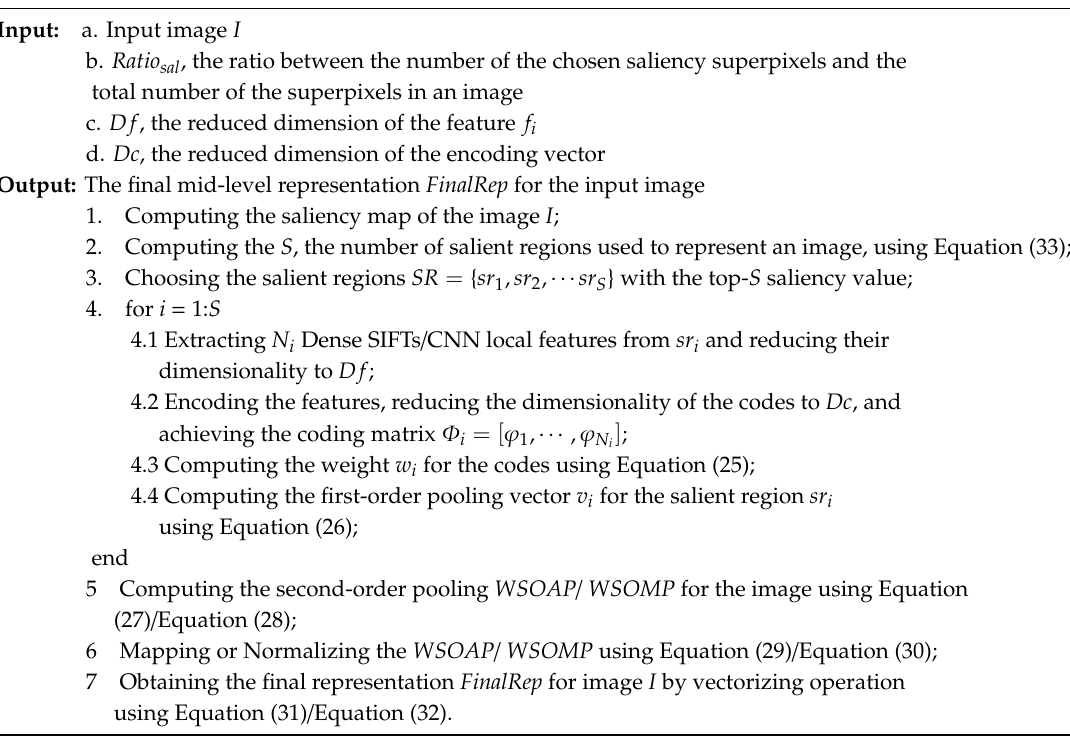
Algorithm 1: Generating the SSNet Mid-Level Image